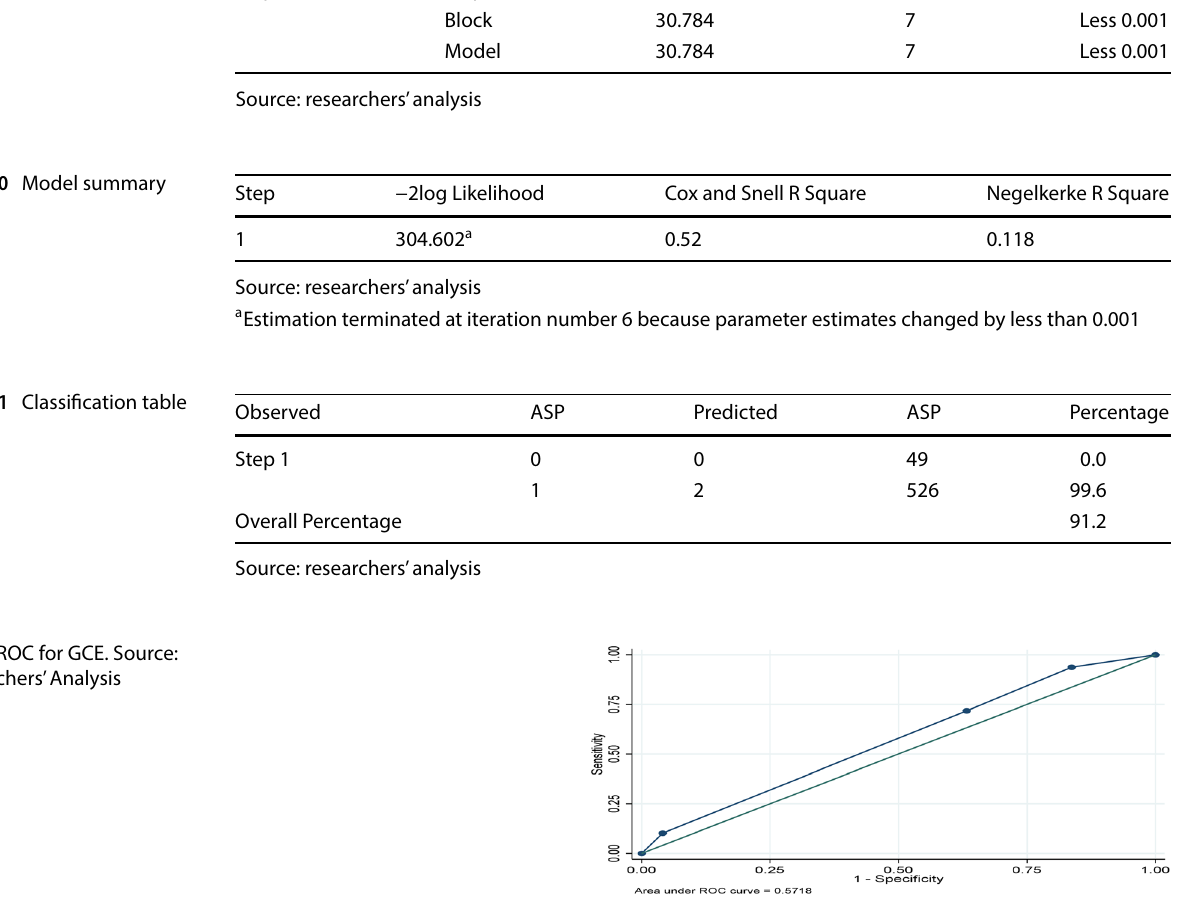
Table 9 Omnibus tests of model coefficients